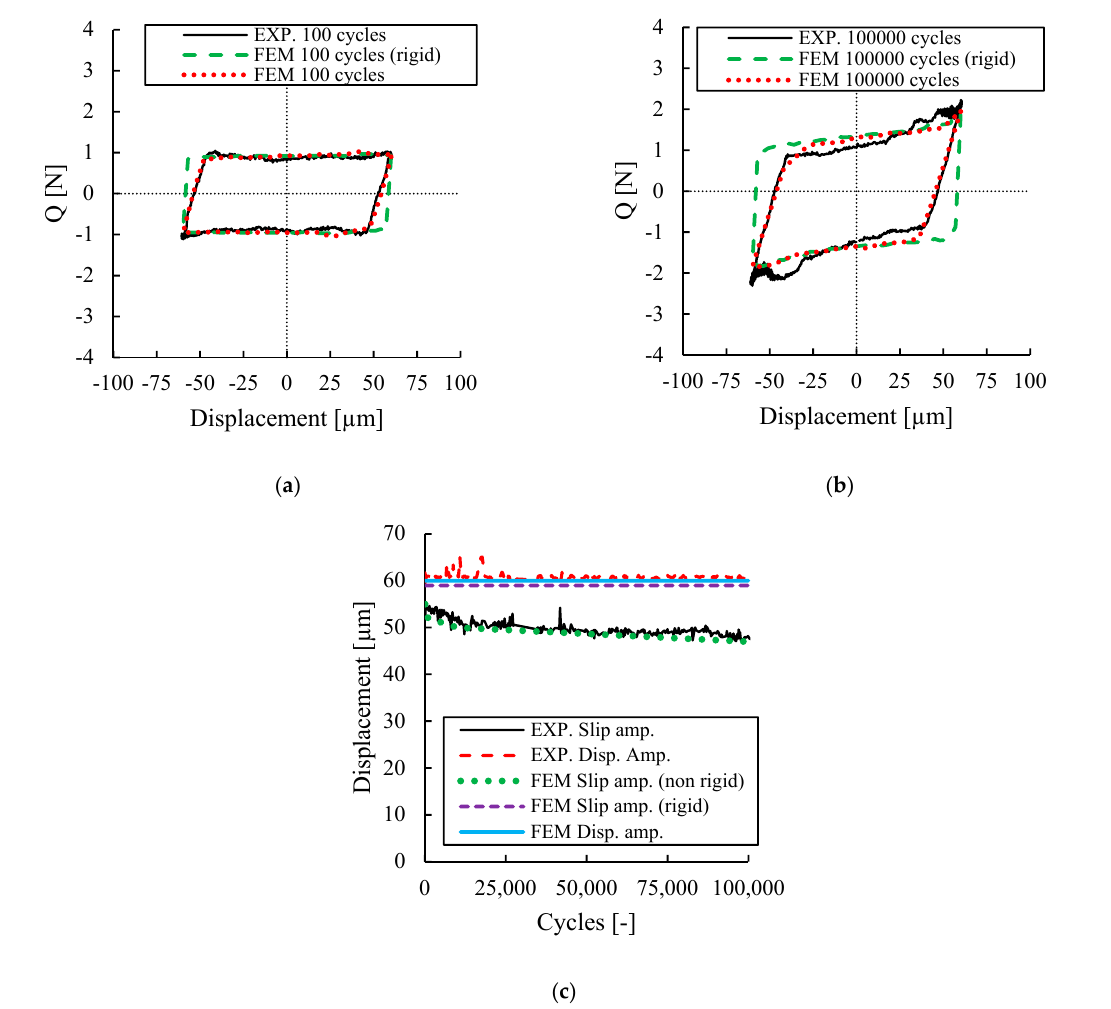
Figure 9. Comparison between the experimental and numerical results. Fretting loops: ( a ) 100 cycles; ( b ) 100,000 cycles. ( c ) Evolution of the slip and displacement amplitude for numerical model considering (non rigid) and not considering the stiffness of the contact system (rigid).